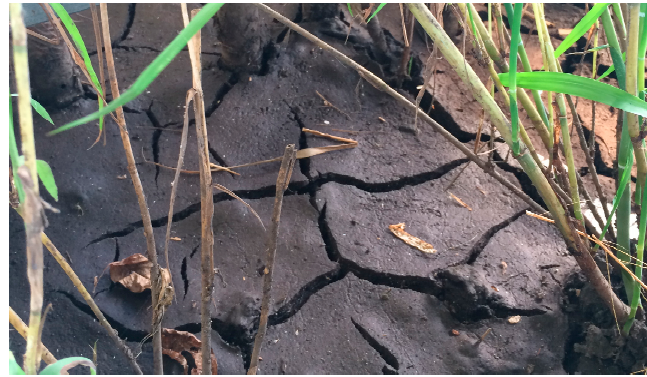
Figure 2. Formation of cracks in the sludge deposit layer during the resting period. These cracks restored a certain level of infiltration capacity due to the formation of “preferential pathway” for the influent.